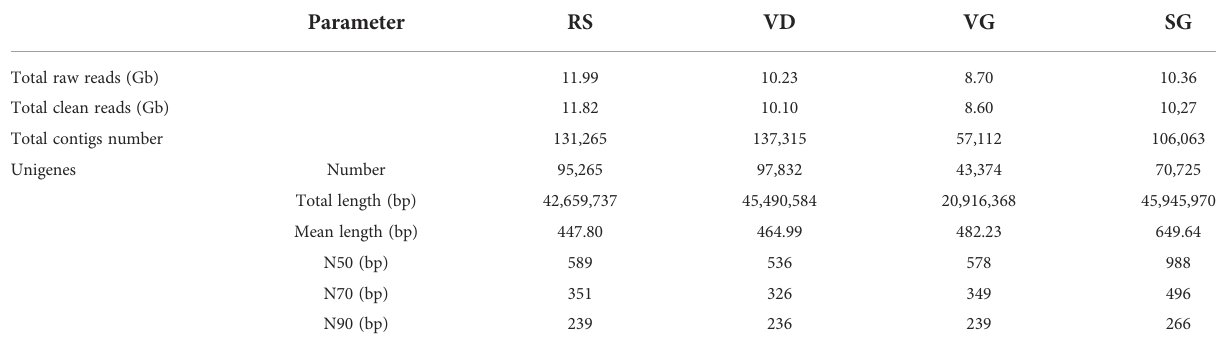
TABLE 1 Statistics of transcriptome sequencing and assembly for the